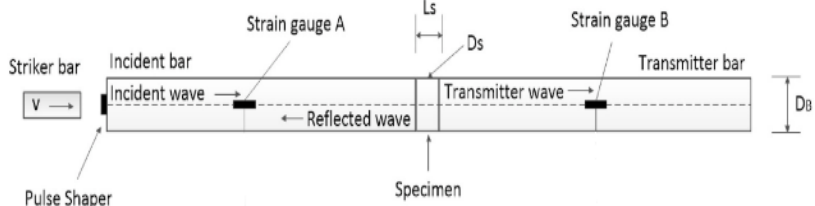
Figure 22. General view of SHPB test system (reprinted from Ref. [86]).